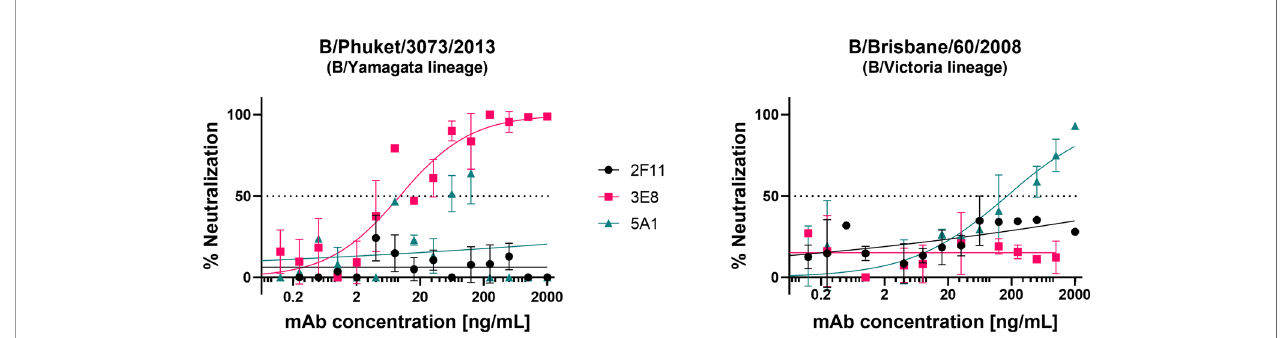
FIGURE 6 | Neutralization of in fl uenza B strains by lineage-speci fi c monoclonal antibodies. Neutralization of in fl uenza B pseudotypes B/Phuket/3073/2013 and B/ Brisbane/60/2008 by monoclonal antibodies 3E8, 2F11, and 5A1, was measured by a luciferase reporter assay. Monoclonal antibodies were serially diluted two-fold from a starting concentration ranging from 2000 ng/mL to 0.0625 ng/mL against all pseudotypes tested. In fl uenza B pseudotypes (1.0x10 6 RLU) were then added to each well. For all plots, each point represents the mean and standard error of two replicates